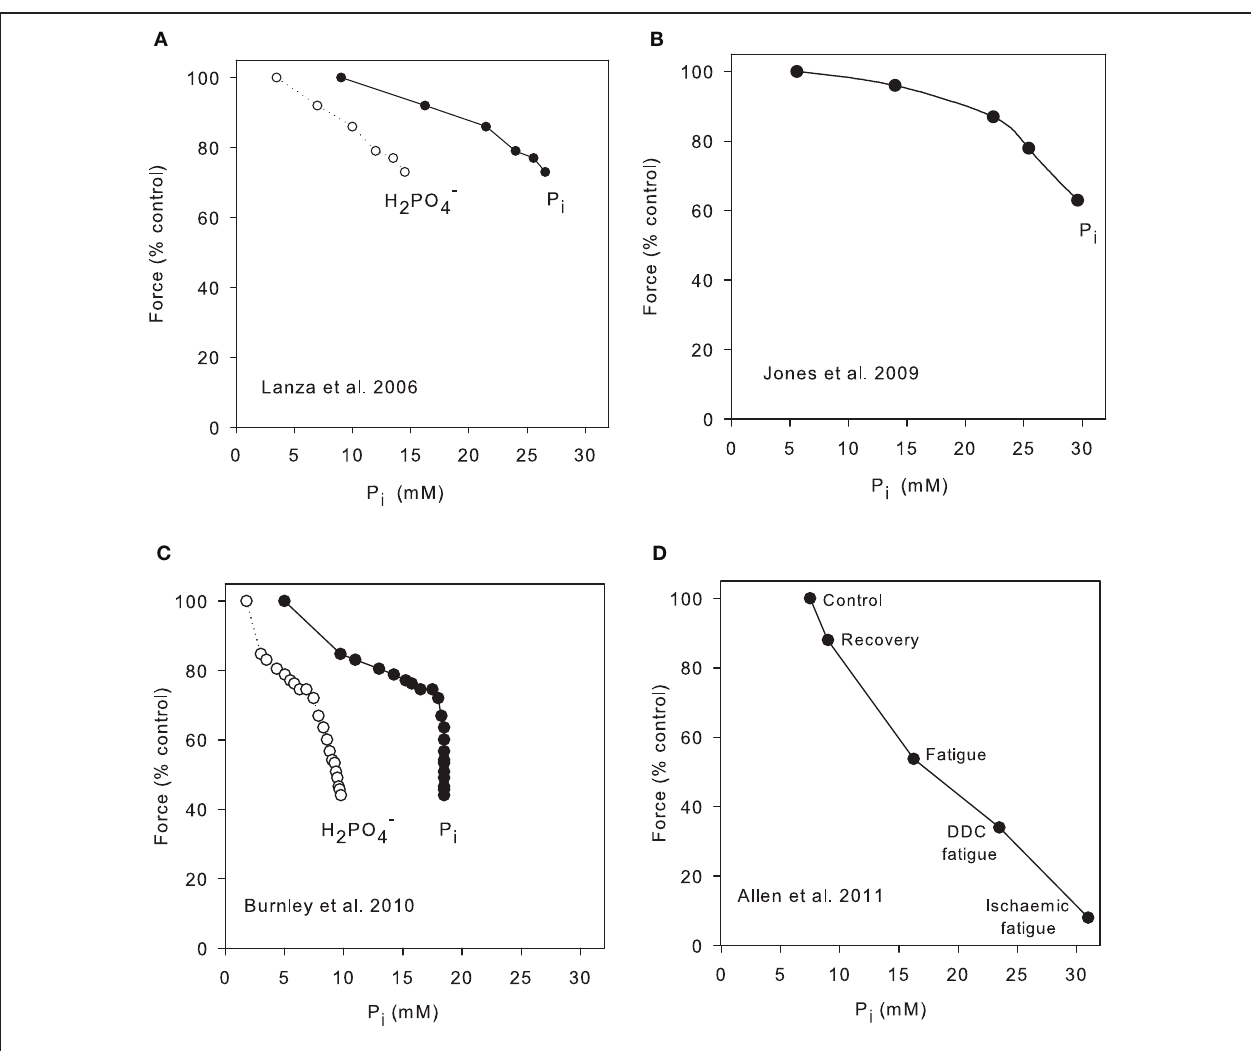
FIGURE 2 | Correlation between P i and force in intact, fatiguing muscle. (A) Human subjects performed six 12s maximal contractions involving dorsiflexion of the ankle and NMR spectra were collected from the tibialis anterior muscle in 12s periods between contractions (Lanza et al., 2006). In the original publication only H 2 PO − 4 was plotted; we have calculated P i on the basis P i = H 2 PO − 4 (1 + 10 pH − 6 . 75 ). (B) Stimulated maximal tetani of the human tibialis anterior muscle under ischaemic conditions. 1.6s tetani with 1.6s intervals between tetani continued for 32s (Jones et al., 2009). (C) Human subjects performed 60 maximal voluntary contractions of the